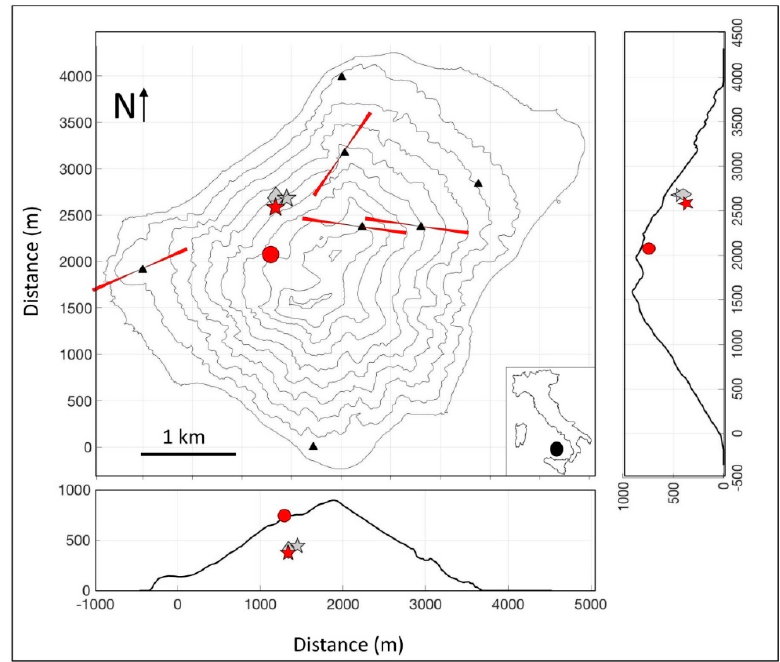
Figure 9. Locations of the precursory signal (red circle) and the VLP (red star, 311 m above sea level) of the 1 December 2017 major explosion, compared with the location of a dataset of 1915 VLP events mainly recorded in the first months of 2012. The gray star represents the centroid obtained from the polarization vectors of the VLPs recorded in 2012 (located 450 m above sea level). The gray diamond represents the area of maximum density of the localizations obtained with the analysis of semblances (386 events), about 400 m above sea level. The uncertainty on the precursory signal and VLP locations are about 100 m and 300 m in the position of the source, respectively. Remote Sens. 2019 , 11 , x FOR PEER REVIEW